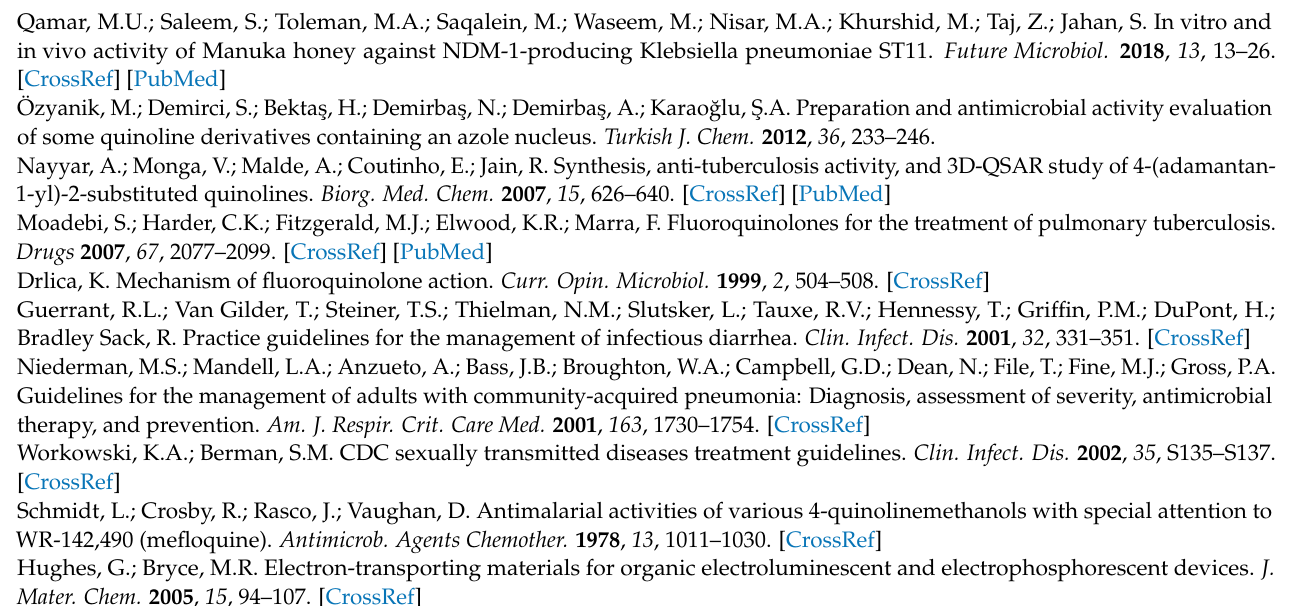
3d , Table S4: Comparison of experimental and theoretical 1H-NMR data of compound 3e , Table S5: Comparison of experimental and theoretical 1H-NMR data of compound 3f, Table S6: Comparison of experimental and theoretical 1H-NMR data of compound 3g , Table S7: Comparison of experimental and theoretical 1H-NMR data of compound 3h